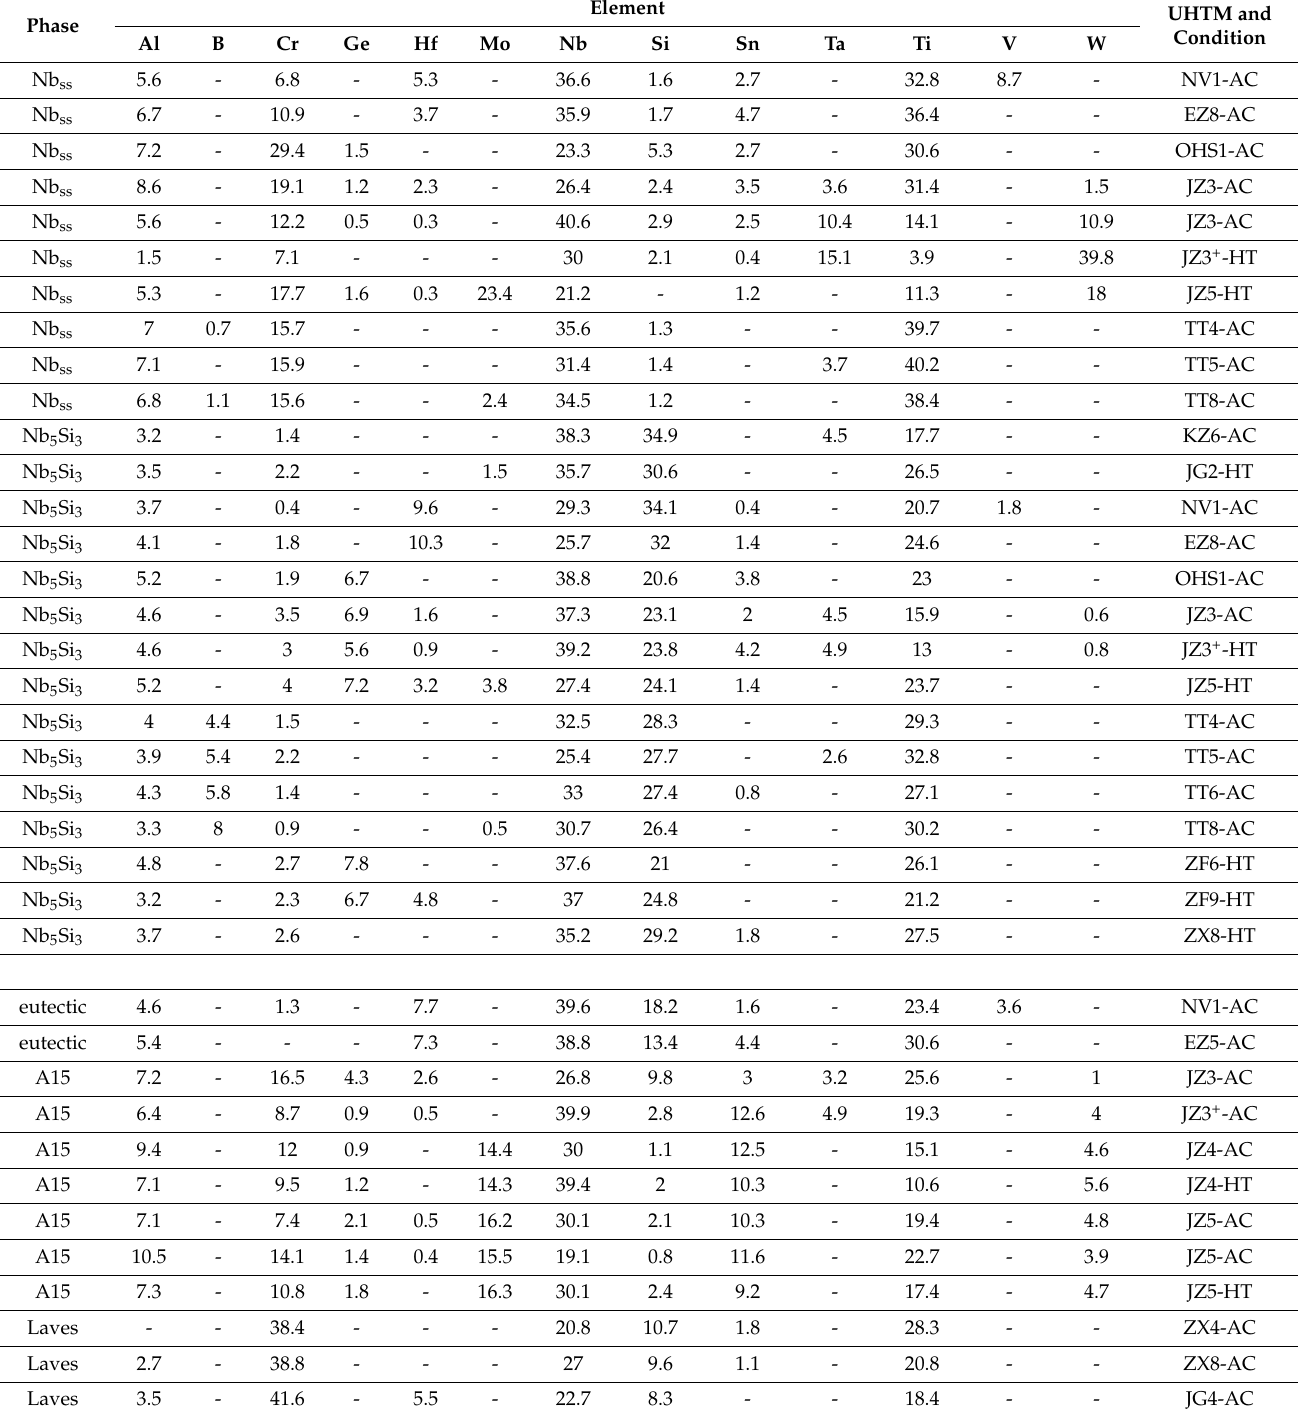
Table 1. Actual chemical composition (at.%) of high-entropy or complex concentrated phases, namely bcc solid solutions (Nb ss ), tetragonal Nb 5 Si 3 silicides, eutectics with Nb ss and tetragonal Nb 5 Si 3 , A15- Nb 3 X (X = Al,Ge,Si,Sn) compounds, and C14-NbCr 2 Laves phase, that can form in RM(Nb)ICs and RM(Nb)ICs/RCCAs, and the metallic UHTM. For nominal compositions of alloys see Appendix A. (AC = as cast, HT = heat